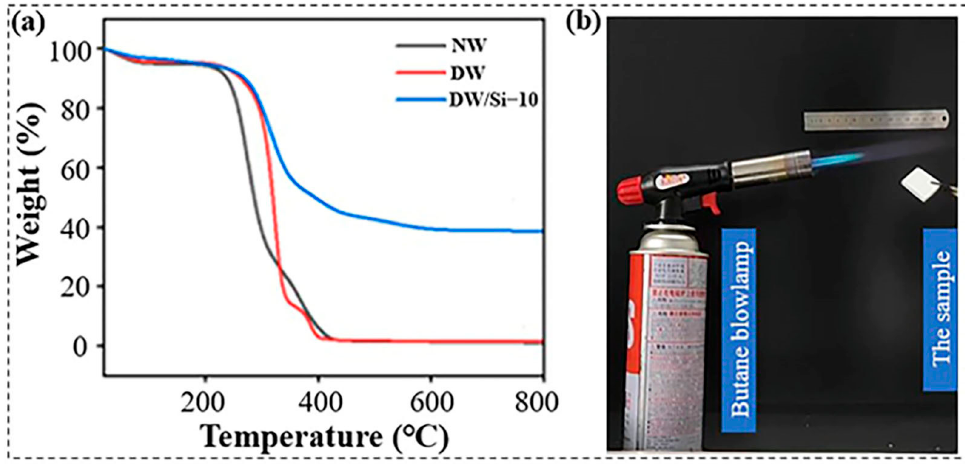
Figure 9. ( a ) TGA curves (measured in air), and ( b ) the experimental setup.